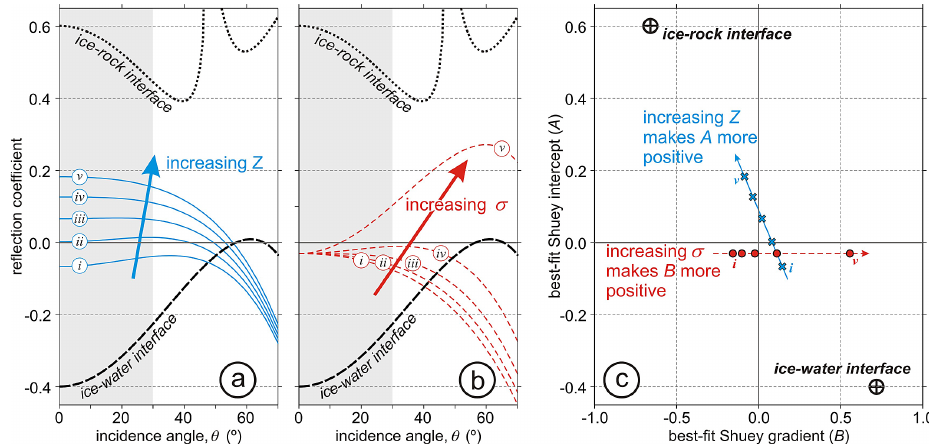
Fig. 1. Example amplitude-versus-angle (AVA) responses for glacier beds overlying till units with acoustic impedance and Poisson’s ratio as specified in Table 1. (a) Acoustic impedance is varied, while Poisson’s ratio is fixed. (b) Poisson’s ratio is varied while acoustic impedance is fixed. Black curves denote example cases of ice-water and ice-rock interfaces (the latter undergoing critical refraction at ∼ 47 ◦ ) . (c) AVA cross-plot of best-fit Shuey terms, A and B , from a linear regression of the Knott-Zoeppritz equations. Blue crosses plot data from (a) , red circles plot data from (b) . Black curves and symbols show reference models of ice-water and ice-bedrock interfaces. Best-fit Shuey terms are calculated only for the first 30 ◦ of incidence (grey shading in a and b ), and have negligible uncertainty.